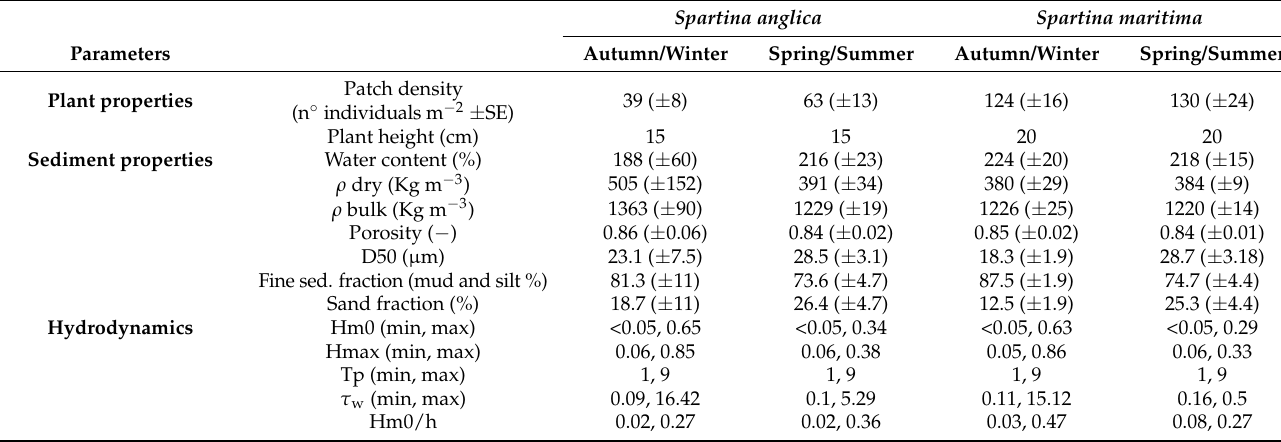
Table 1. Summary data for the two Spartina species stations. ρ dry = sediments dry density; ρ bulk = sediments bulk density; D 50 = Sediment mean particle size; Hm0 = mean spectral wave height (m); Hmax = maximum wave height (m); Tp = wave